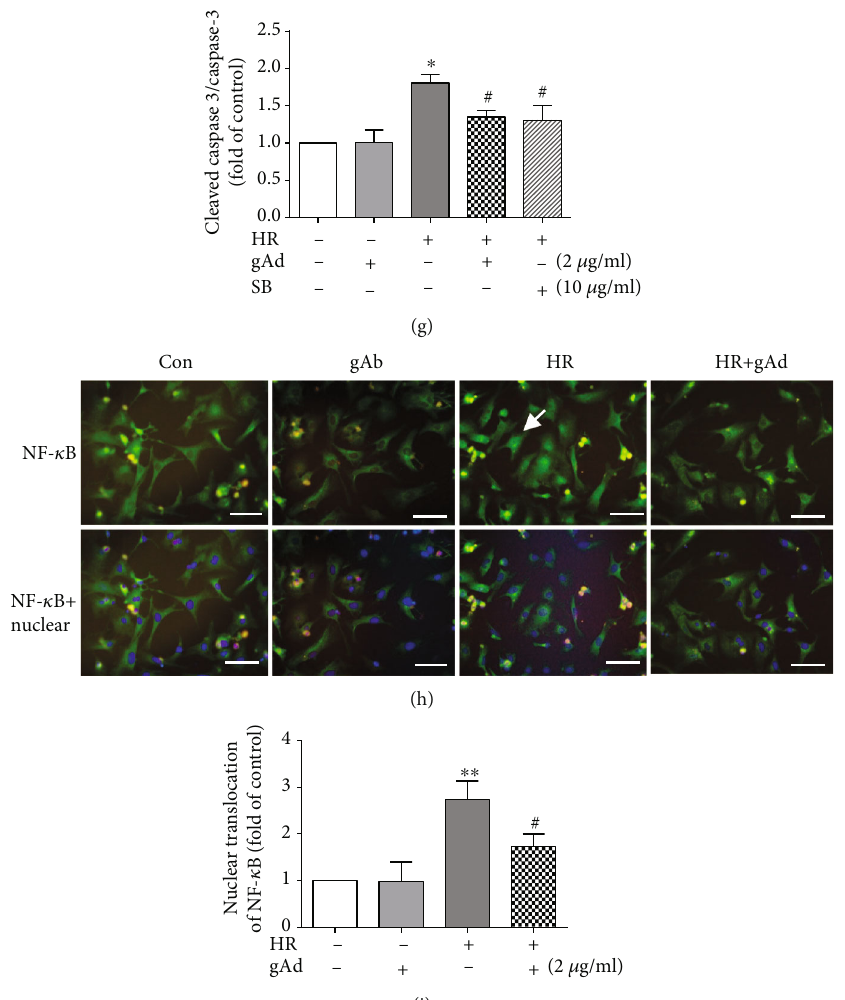
Figure 6: gAd inhibits hypoxia/reoxygenation-induced necroptosis and apoptosis in cardiomyocytes by disrupting the p38/NF- κ B signaling pathway. (a – g) Western blotting and average data of p38, NF- κ B, Bcl-2, Bax, RIP1, RIP3, and (cleaved) caspase-3 protein abundance in the control, gAd, HR, HR+gAd, and HR+SB groups ( n = 3 ). (h) Immuno fl uorescence double staining for NF- κ B (green) localization. The nuclei of the cells were counterstained with Hoechst (blue) ( n = 3 , scale bar, 50 μ m). (i) The bar fi gures show the quanti fi cation data on NF- κ B translocation. ∗ P < 0 : 05 and ∗∗ P < 0 : 01 vs. the control group; # P < 0 : 05 vs. the H/R